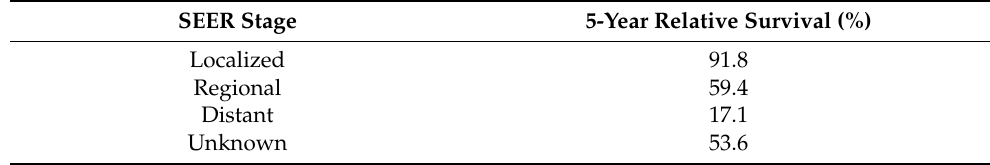
Table 3. Five-year relative survival for different CC stages according to SEER database